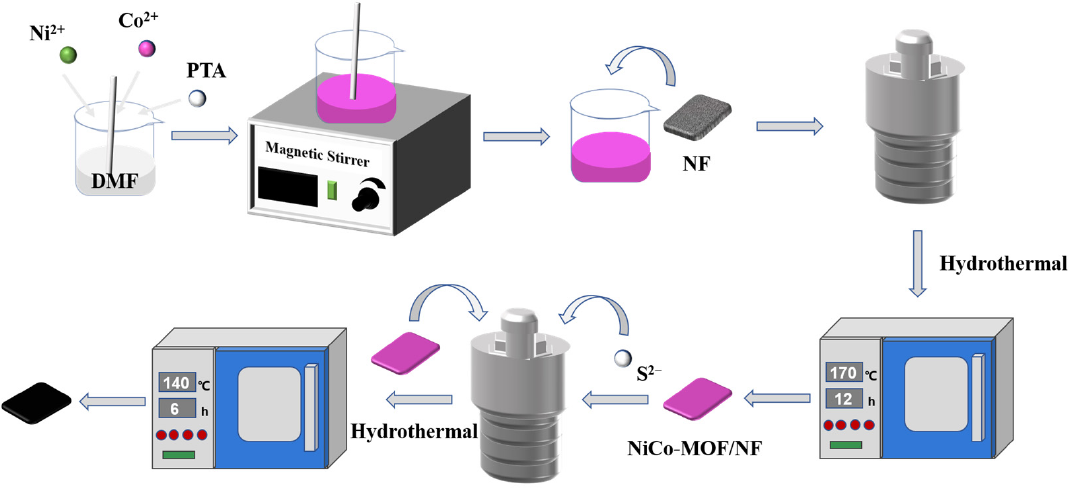
Figure 1. Illustration of the preparation process from NiCo-MOF to NiCo-S.